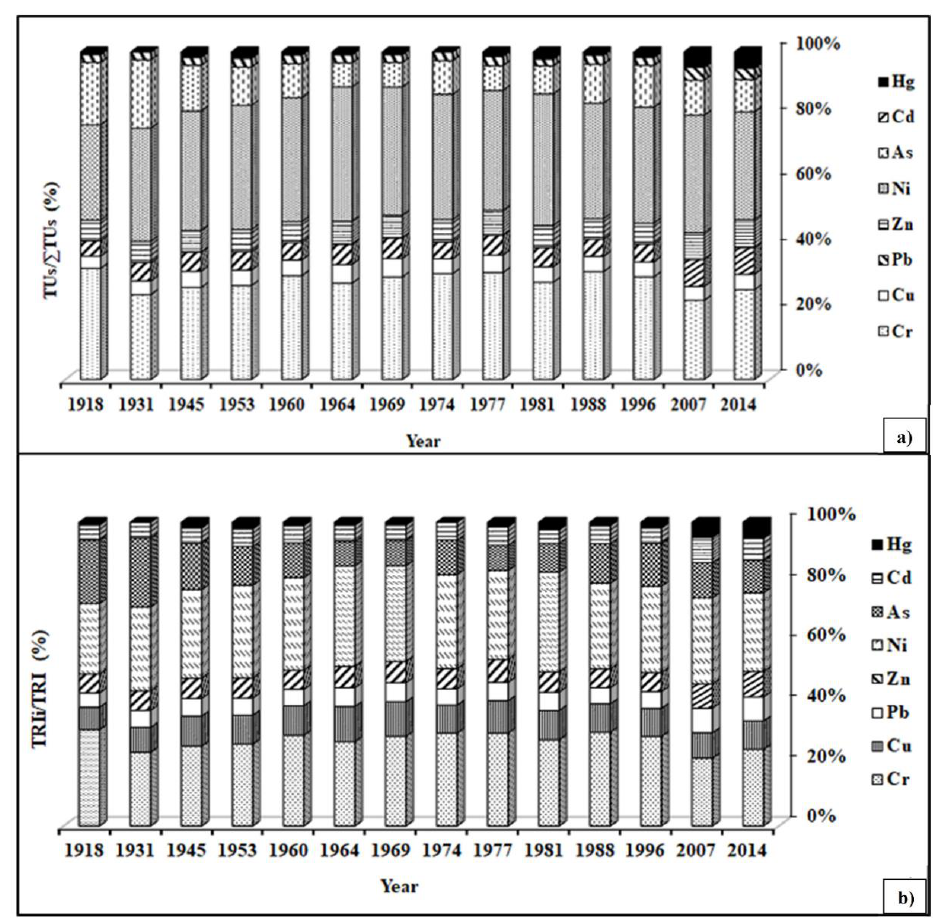
Figure 6. Temporal distribution of TUs/∑TUs ratio of investigated heavy metals ( a ) and of toxic risk index of investigated heavy metals ( b ).